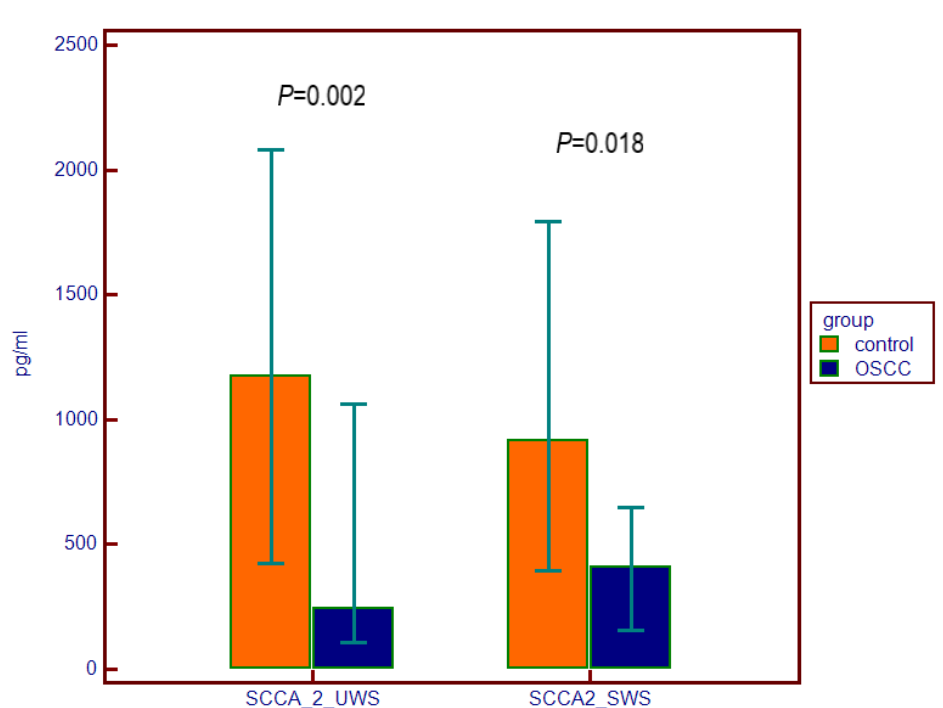
Figure 1. SCCA1 levels (pg/mL) in unstimulated whole saliva (UWS) and stimulated whole saliva (SWS) in patients with oral squamous cell carcinoma (OSCC) and in the control group expressed with median and the 25th–75th percentiles.